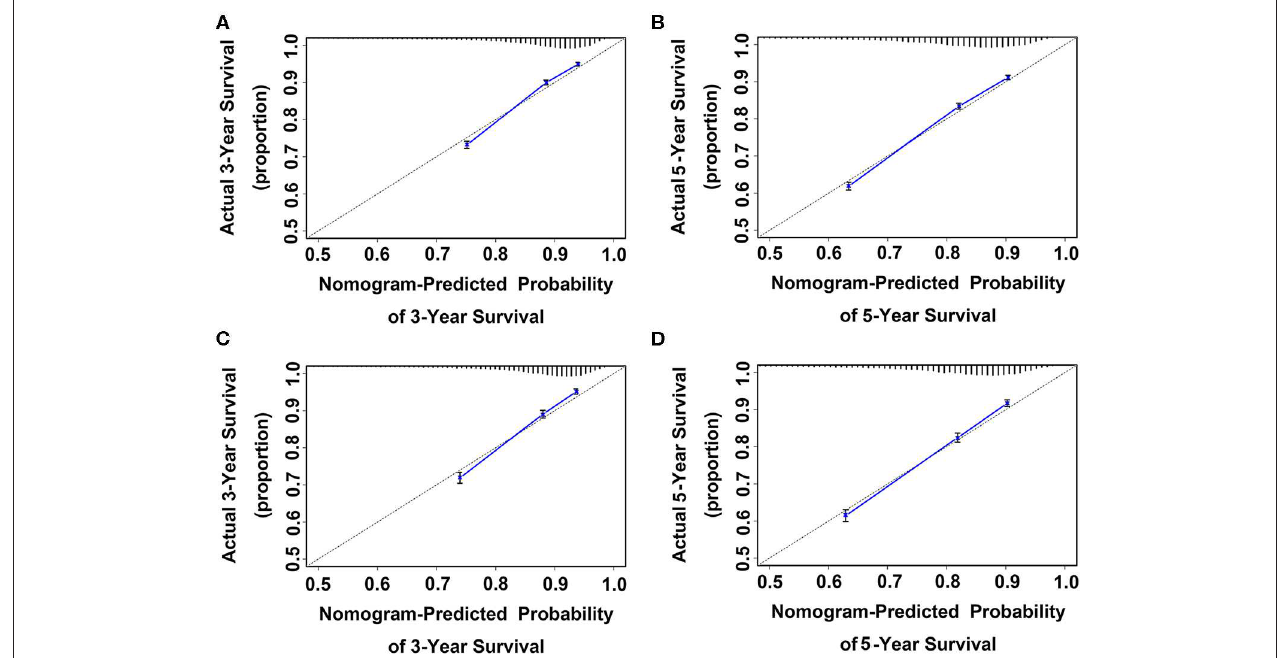
FIGURE 5 | Calibration curve for predicting patient survival at (A) three and (B) five years in the training cohort and at (C) three and (D) five years in the validation cohort. Nomogram-predicted probability of OS is plotted on the x-axis; actual OS is plotted on the y-axis. Shorter distance between two curves indicates higher accuracy.